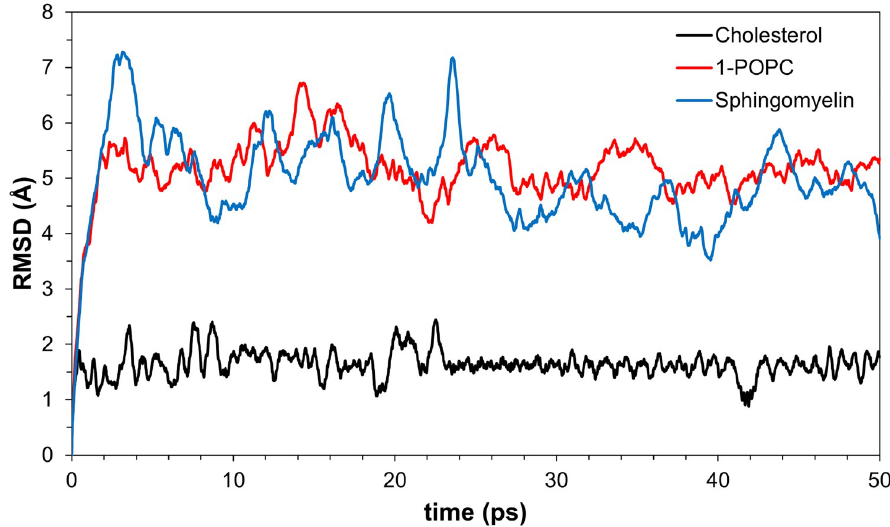
Fig 8. Variations of RMSD values in molecular dynamics simulations of the three membrane